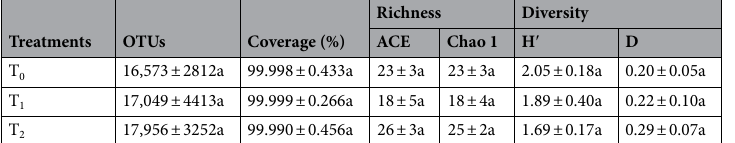
Table 3. Diversity of soil ammonia-oxidizing archaea (AOA) as affected by fertilization and irrigation in 2018. T 0 = Traditional irrigation; T 1 = Traditional irrigation and fertilization practice; T 2 = Water-saving irrigation and optimizing fertilization. Operational taxonomic units (OTUs); Abundance-based coverage estimators (ACE); . Values (means ± SD) with different lower-case letters in a column are significantly different at P < 0.05 according to the Duncan test.